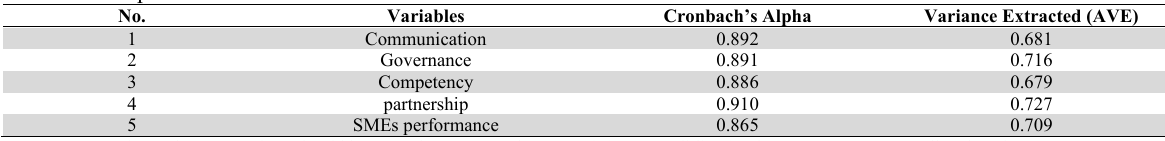
Cronbach's Alpha Values